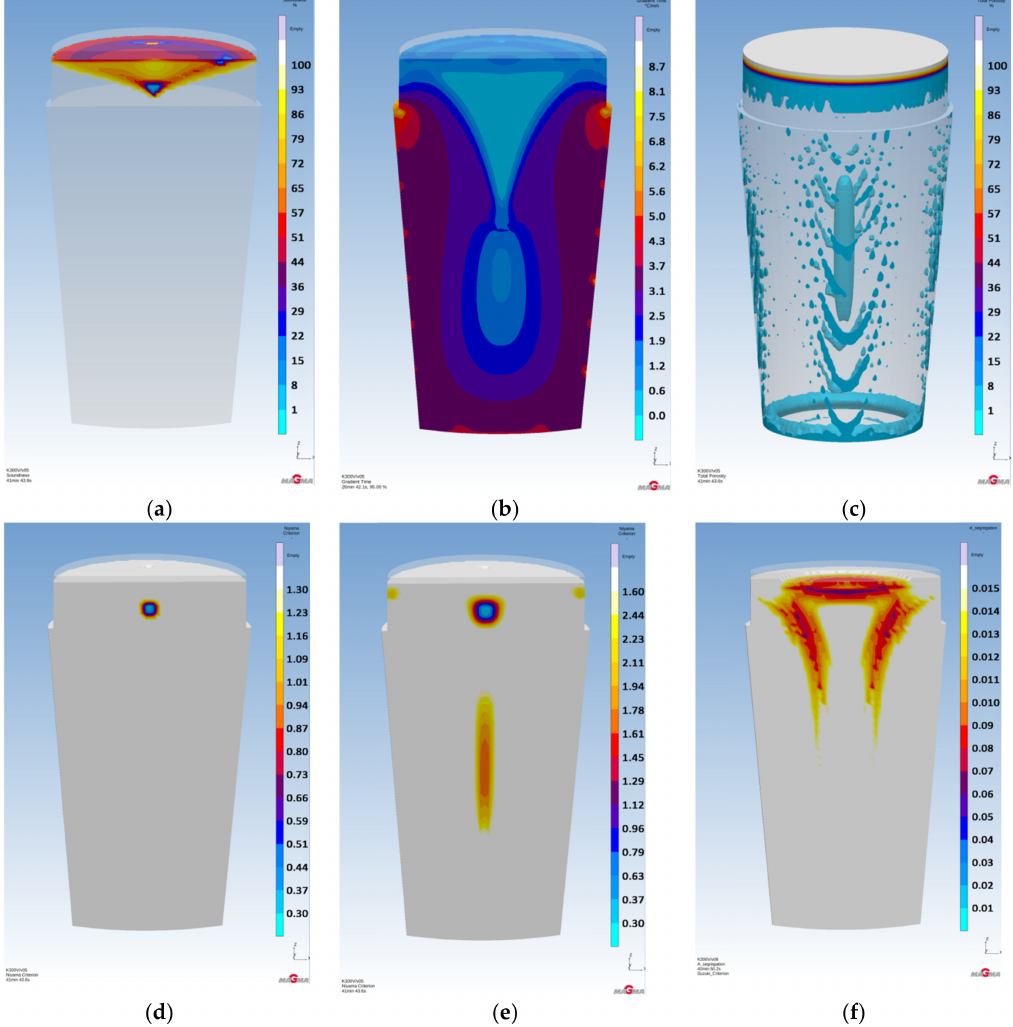
Figure 4. The results of criteria: ( a ) Soundness %; ( b ) Gradient Time 26 min 42.1 s; ( c ) Total Porosity %; ( d ) Niyama 0.3–1.3 K 1/2 s 1/2 mm − 1 ; ( e ) Niyama 0.3–2.6 K 1/2 s 1/2 mm − 1 ; ( f ) A-segregation (Suzuki criterion) 0.0–0.015 K s − 1 ( µ m s − 1 ) 1.1